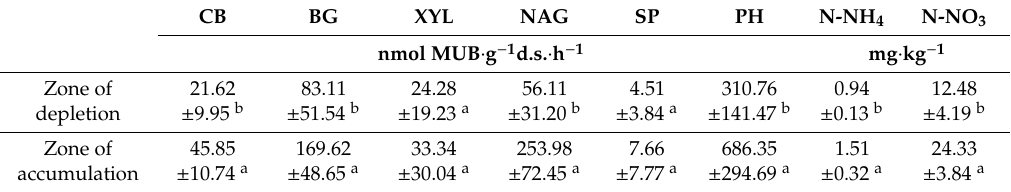
Table 3. Enzyme activity and mineral form of nitrogen of soil of depletion and accumulation zone.